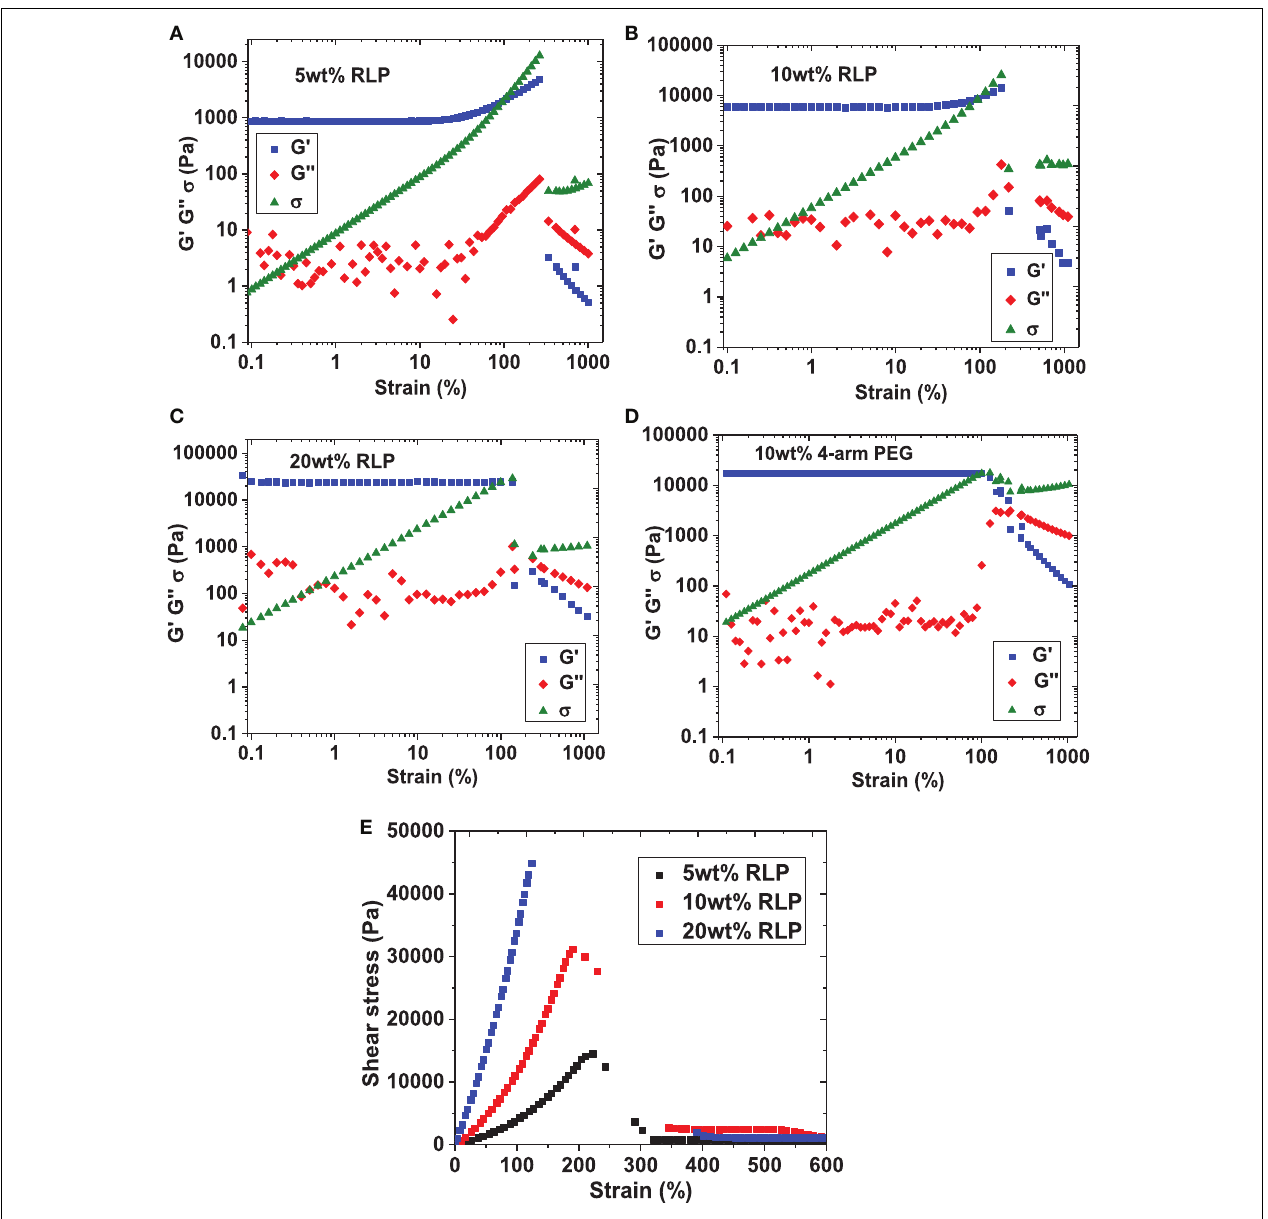
FIGURE 3 | Strain sweeps of RLP hydrogels at (A) 5wt%, (B) 10wt%, and (C) 20wt% polypeptide concentrations and (D) 10wt% 4-arm PEG hydrogels. (E) Summary of steady shear flow, strain-to-break experiments on